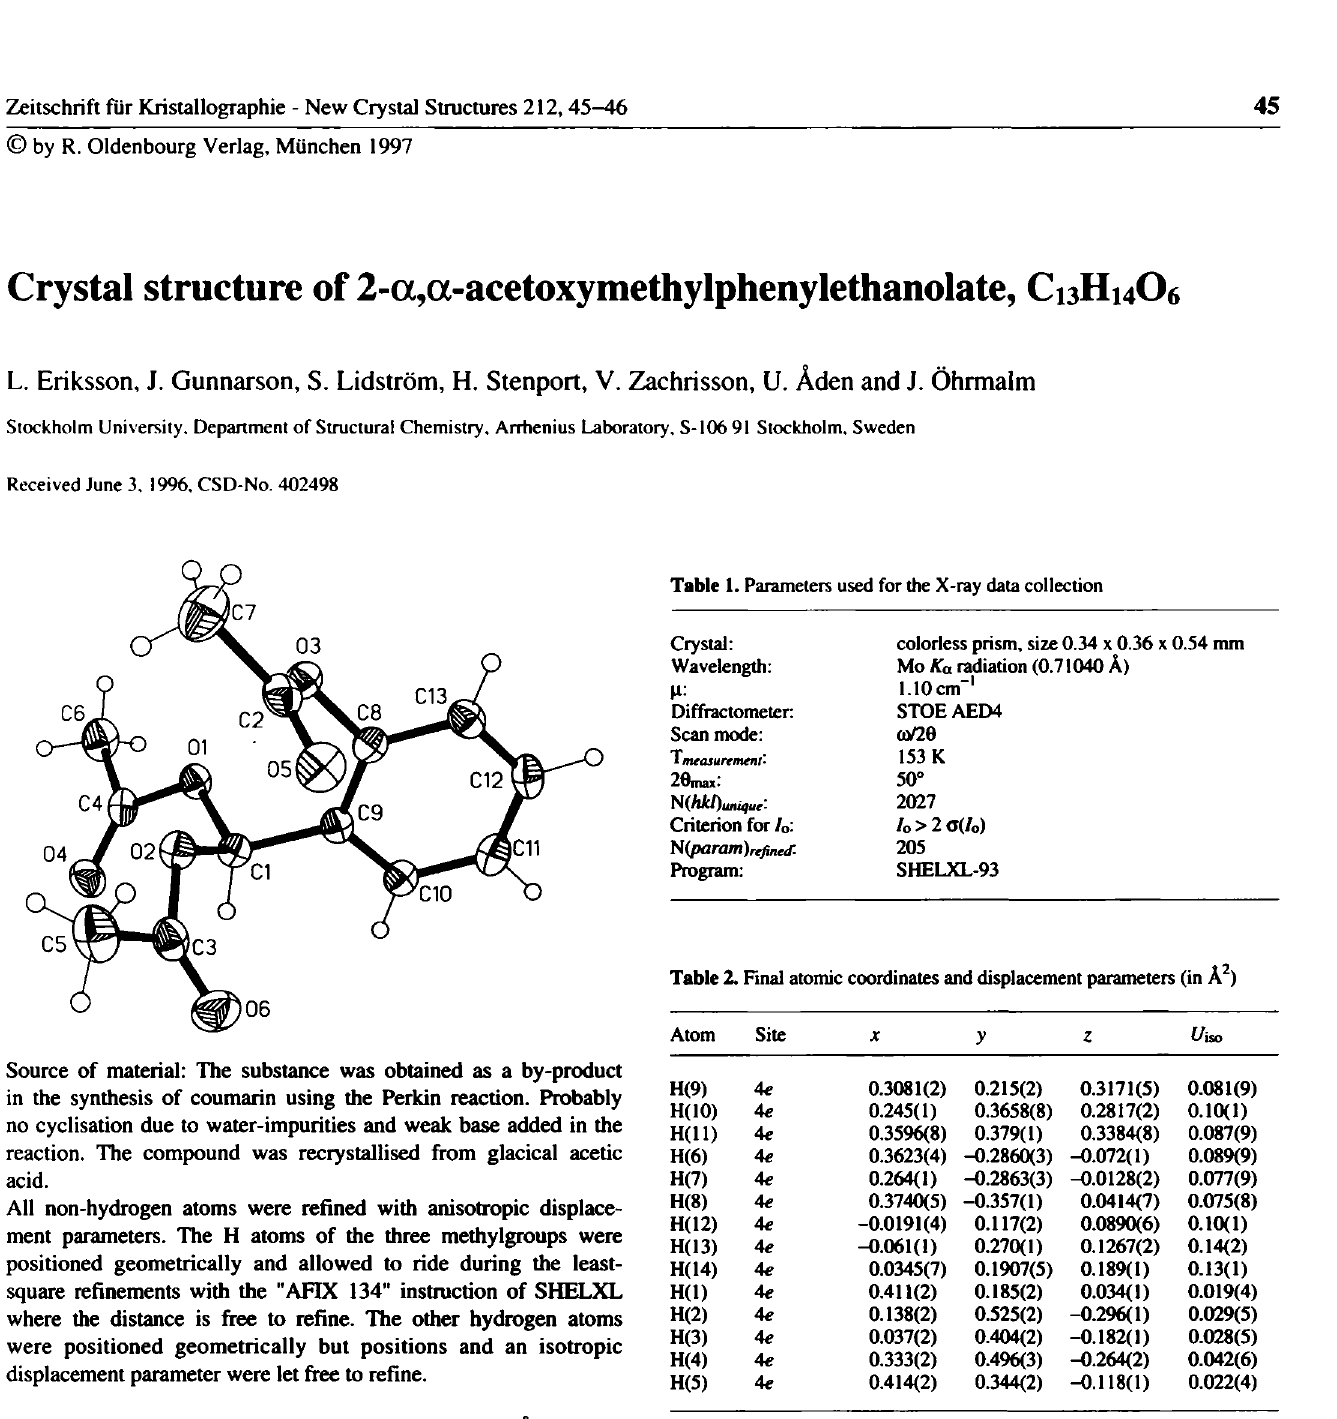
Table 2. Final atomic coordinates and displacement parameters (in Â 2